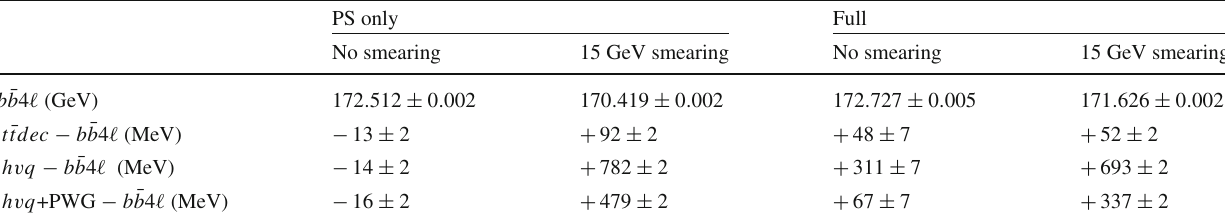
Table 12 Differences of h v q and t ¯ tdec with respect to b ¯ b 4 (cid:4) , all showered with Herwig7.1 . The result obtained using the Herwig7.1 internal POWHEG implementation of top decay, rather than MEC, labelled as h v q +PWG, is also shown PS only Full No smearing 15 GeV smearing No smearing